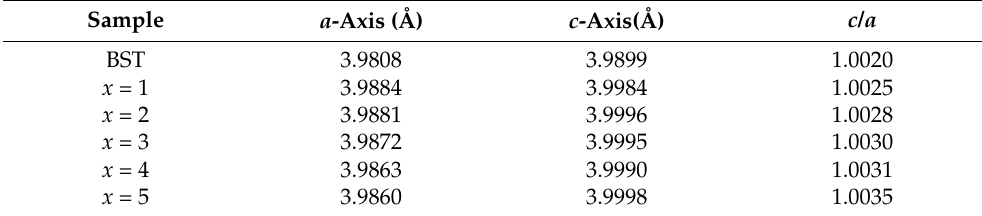
Table 2. Lattice parameters of the BST and BST- x mol% MgO ( x = 1, 2, 3, 4, 5)